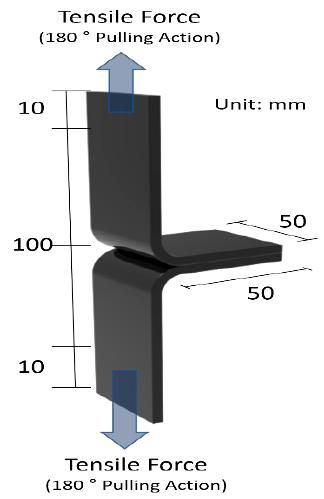
Figure 3. A 180 ◦ peel-off resistance test method Figure 3. A 180° peel-off resistance test method concept.